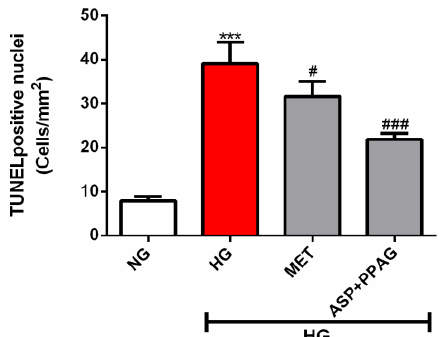
Figure 5. The additive effect of aspalathin (ASP) and phenylpyruvic acid-2- O -β- D -glucoside (PPAG) in comparison to metformin (MET) on protecting against DNA damage. H9c2 cardiomyocytes were exposed to 33 mM glucose (HG) for 48 h before treatment with a combination of ASP and PPAG, as well as MET, at a dose 1 μM for 6 h. Results are expressed as the mean ± SEM of three independent experiments relative to the normal glucose (NG) control (5.5 mM). *** p < 0.001 versus NG control; # p < 0.05, ### p < 0.001 versus HG control.